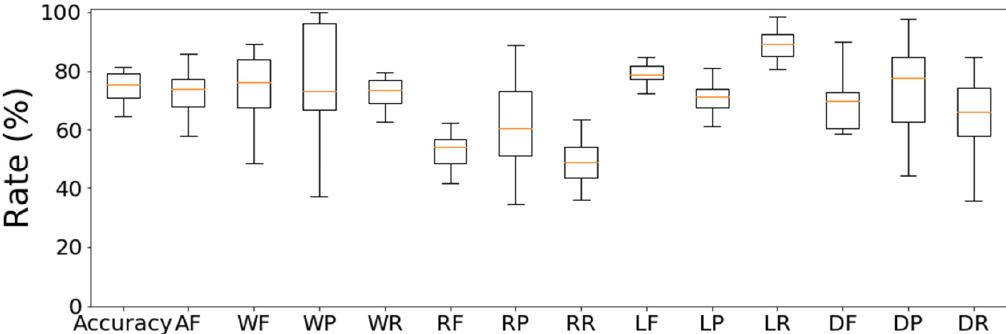
Figure 11. The estimated results of accuracy, F-score, precision, and recall ( n = 15).